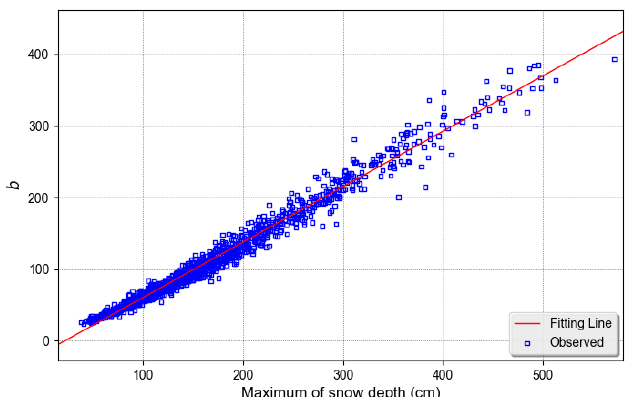
Figure 6. Scatterplot of SWE versus snow depth and the polynomial fitting results in Ptran.